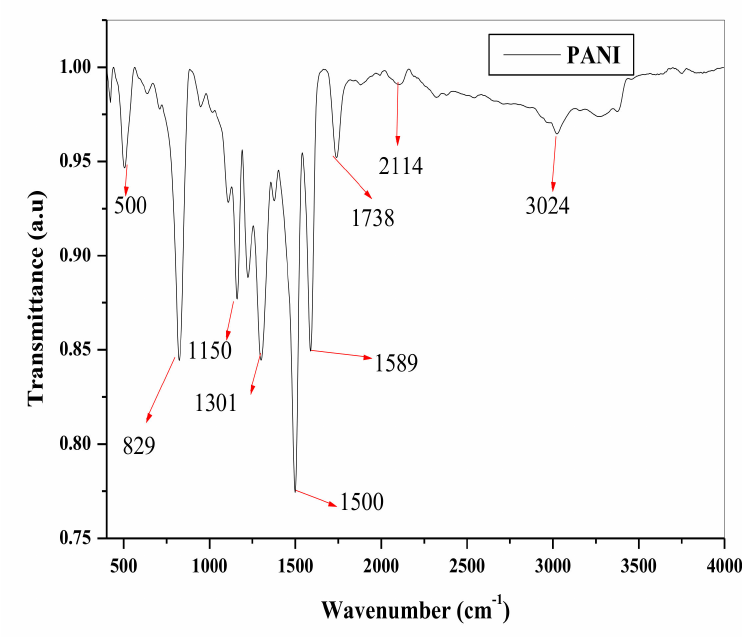
Figure 3. FTIR spectral of PANI.